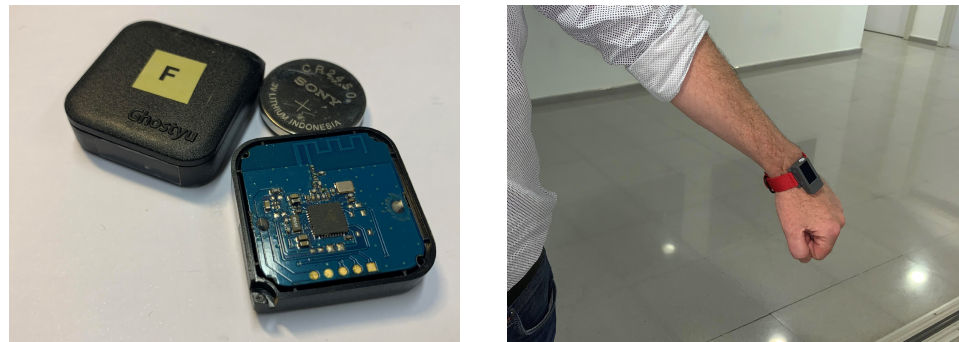
Figure 2. BLE Beacon ( left ) and an ESP32-based wearable receiver used to implement the virtual fence detection ( right